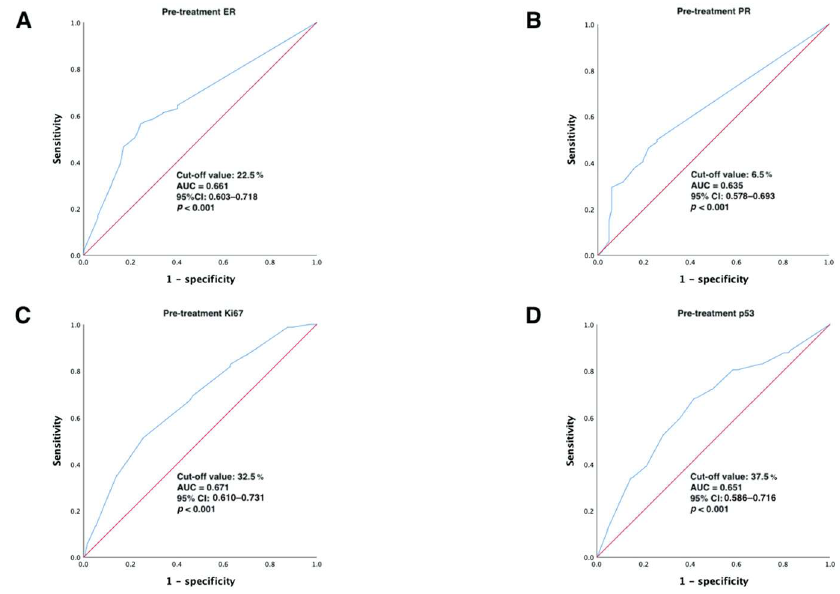
Figure 2. ROC analysis showing the best discriminative value to predict pCR for ( A ) ER; ( B ) PR; ( C ) Ki67; ( D ) p53 in the primary cohort. Abbreviations: ROC, receiver operating characteristic; AUC, area under the curve; CI, confidence intervals; ER, estrogen receptor; PR, progesterone